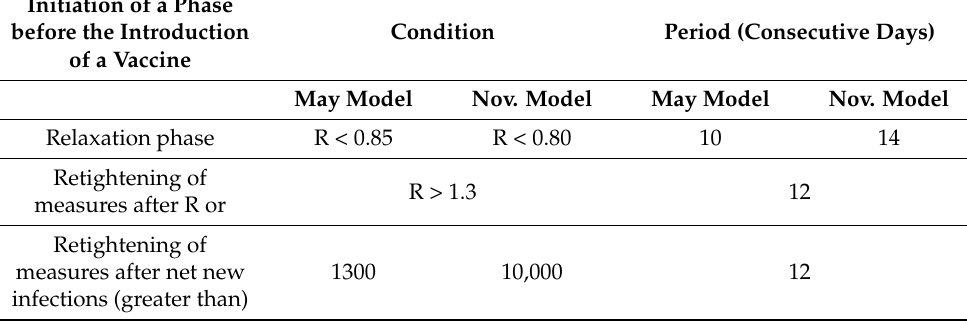
Table A3. Relaxation and retightening of